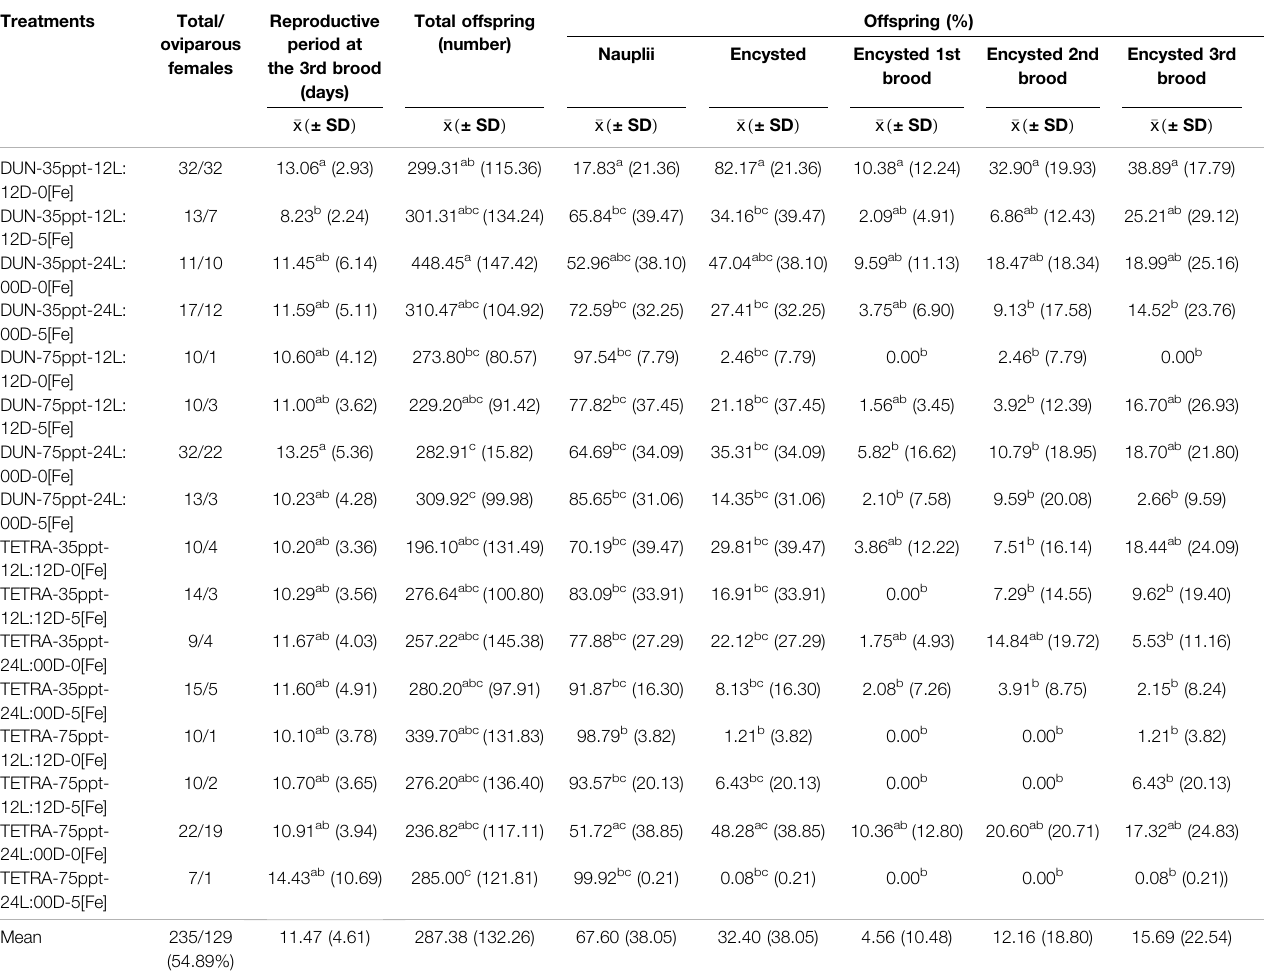
TABLE 3 | Summary of reproductive parameters of 16 treatments recorded for Barro Negro population.